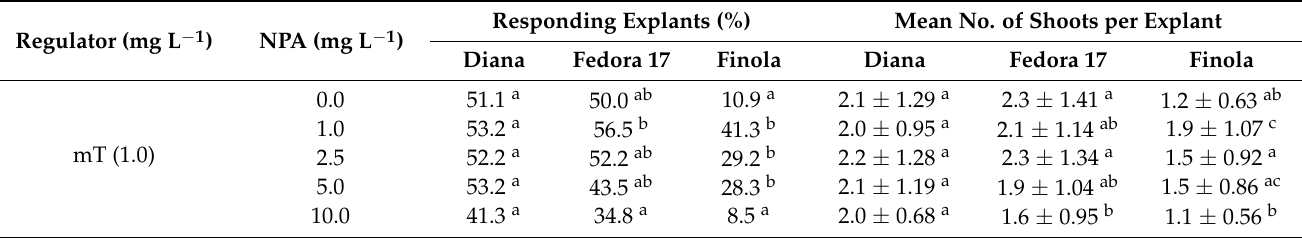
Table 2. Effect of NPA and genotype on shoot regeneration of C. sativa epicotyl explants after three weeks of culture on medium with mT.